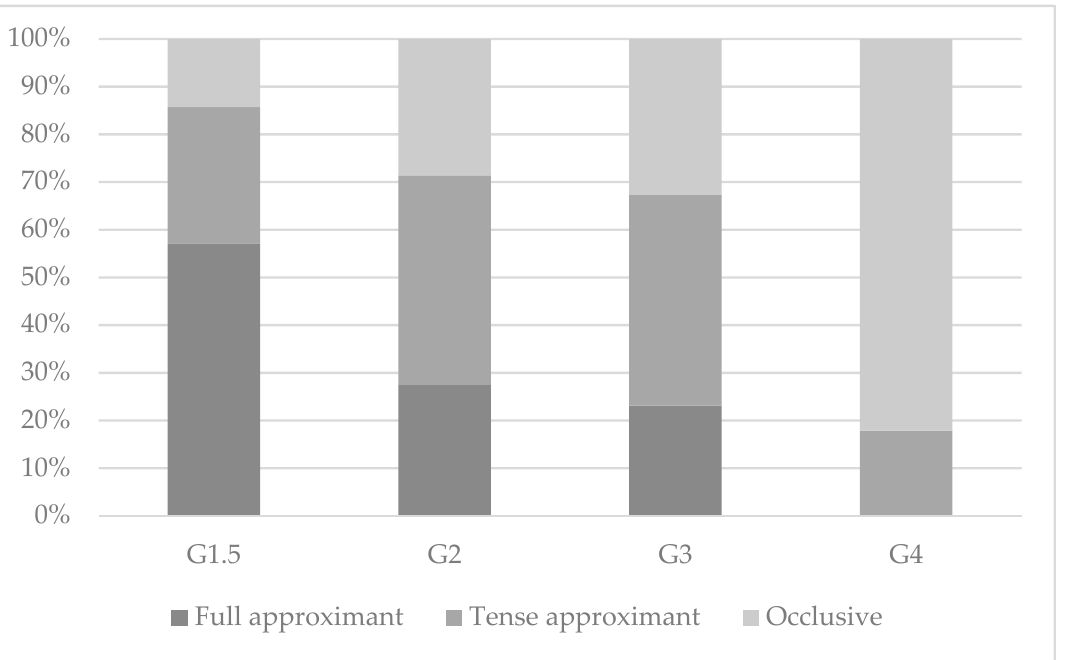
Figure 8. Rates of /g/ production types by generation.